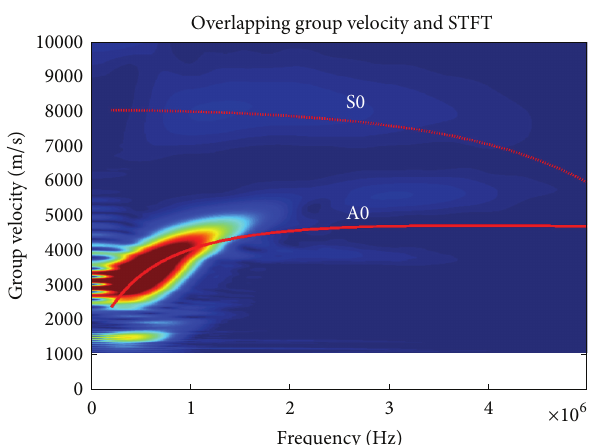
Figure 7: STFT result overlapped with group velocity.